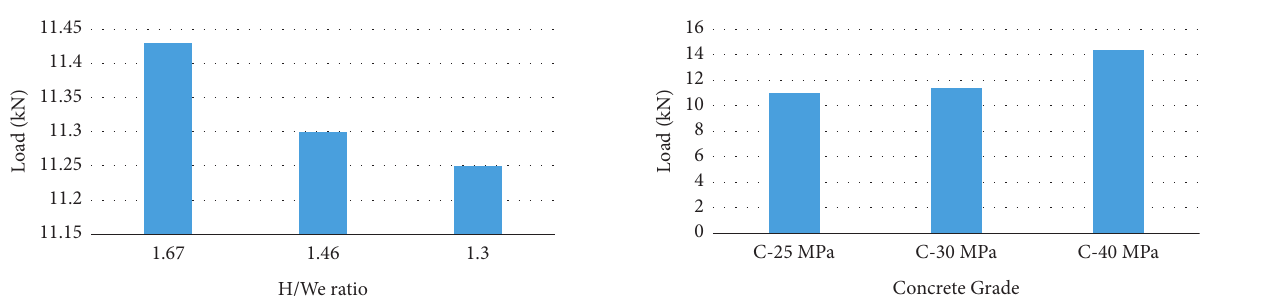
Figure 11: Effect of aspect ratio ( H / W capacity of the connection.